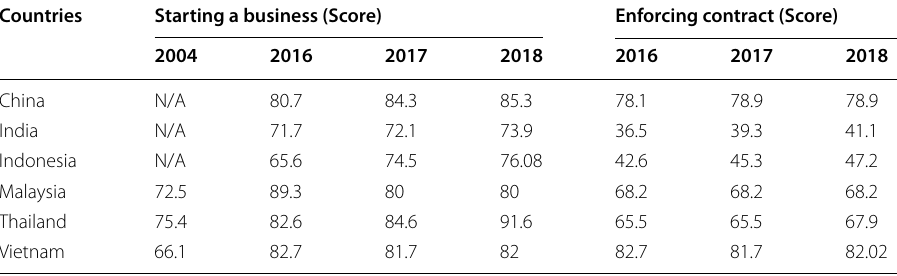
Table 8 Data for starting a business and contract enforcement in selected East Asia major exporting countries. Source: Doing Business Database, The World Bank Countries Starting a business (Score) Enforcing contract (Score)